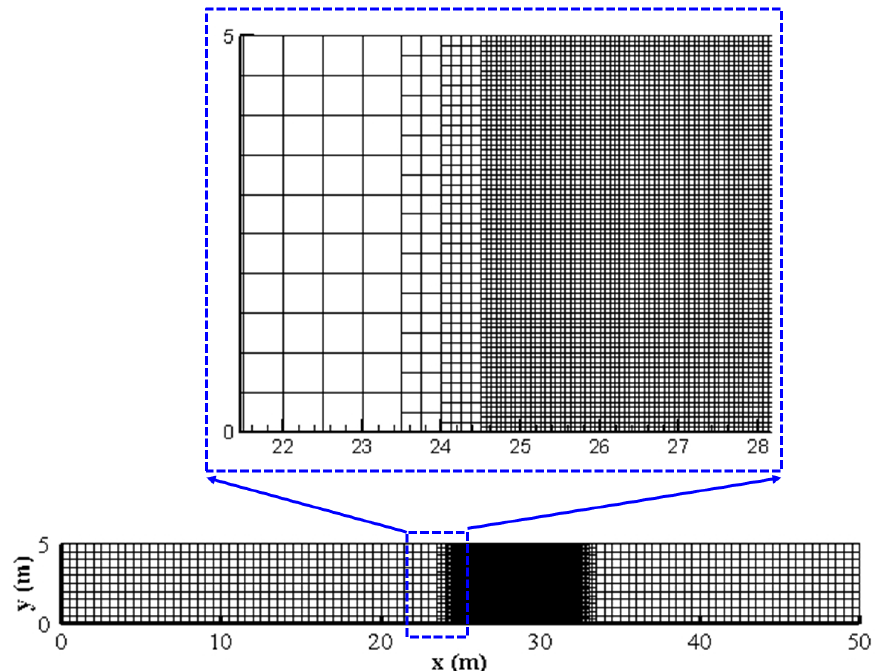
Figure 7. The computational grid for the dam break flow over triangular